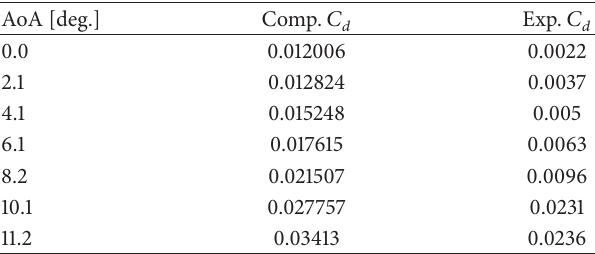
Table3:Computedfullyturbulentdragcoefficientsandexperimen- tal drag coefficients.